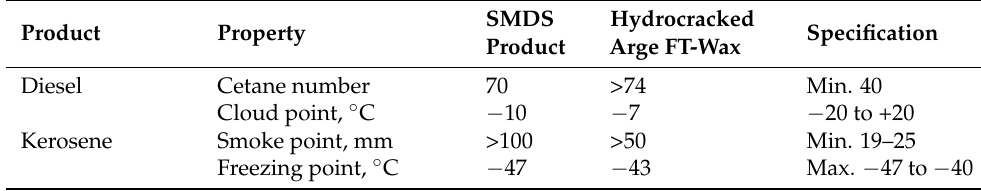
Table 6. Product quality. Adapted from Sie [104] and Gregor